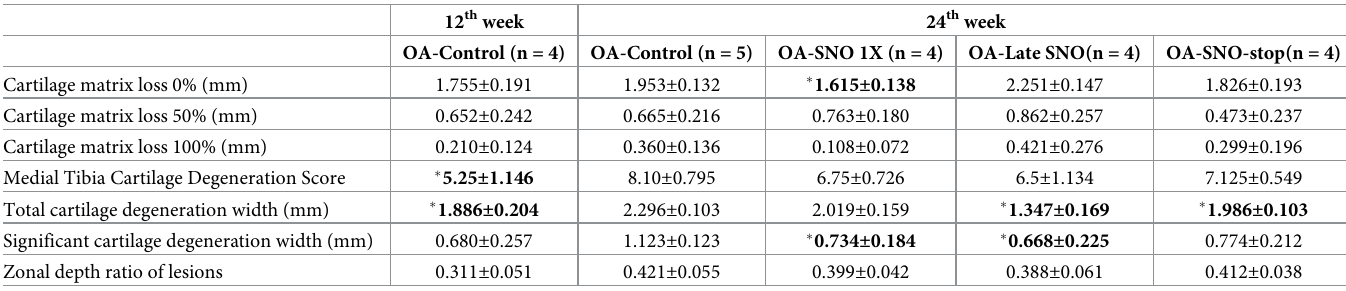
Table 1. Histological scoring of OA knee